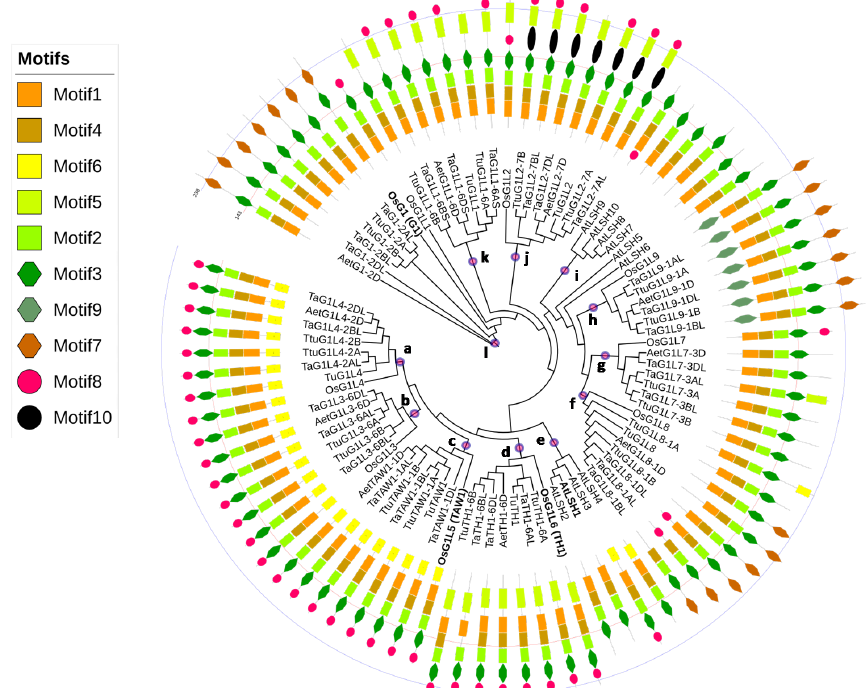
Figure 2. Phylogenetic relationship and conserved motifs of the selected ALOGs. A total of 86 ALOG proteins from Arabidopsis thaliana, Oryza sativa subsp. Japonica, Triticum urartu (AA), Aegilops tauschii (DD), Triticum turgidum ssp. Dicoccoides (AABB), and Triticum aestivum (AABBDD) were selected to construct the phylogenetic tree and identify the conserved motifs. The blue dots filled with red in the clades and the letters (a – l) show the 12 main groups. The genes written in bold font have known functional ALOG genes in Arabidopsis and rice. The names of species are abbreviated to two or three letters and detailed information is provided in Table 2. Each conserved motif is illustrated with a specific color and shape, and the distribution of the motifs corresponds to their positions. The first line labels the 143rd amino acid and the second line labels the 238th amino acid position in all sequences.